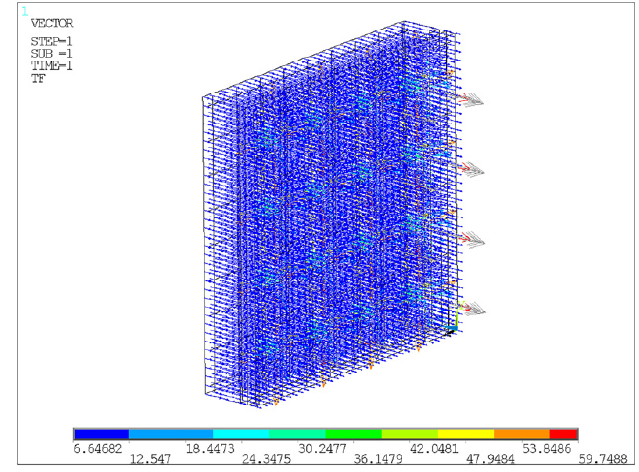
Figure 16. S-Rebar heat flux vector diagram.